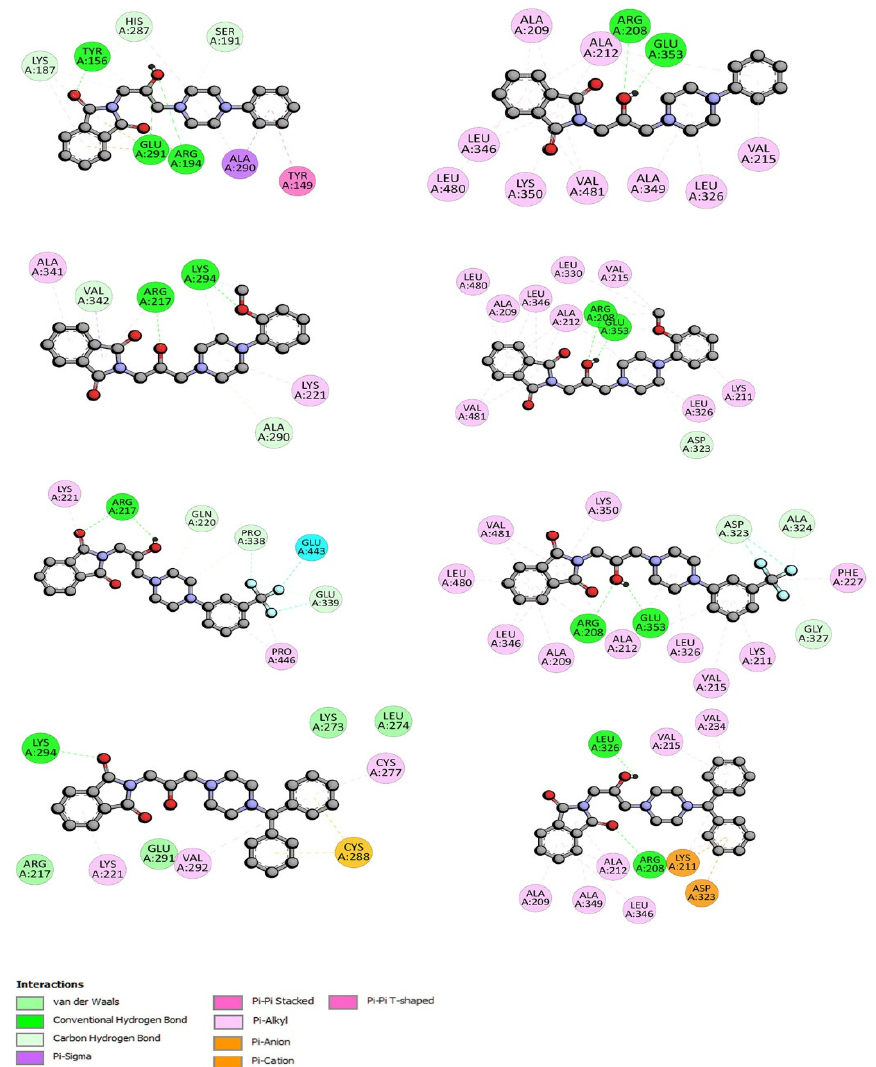
Figure 8. The 2D interaction plots of compounds F1–F4 with BSA in site I ( left ) and site II ( right ).